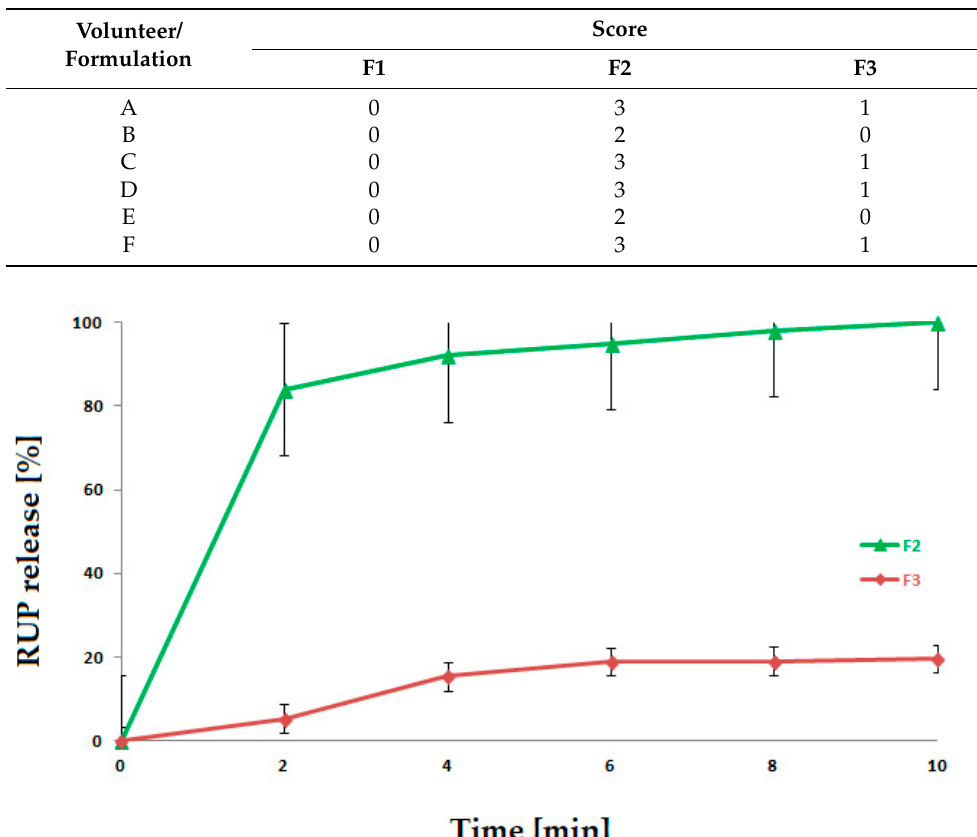
Table 2. Organoleptic assessment of formulated ODFs: 0—without bitterness, 1—slight bitterness, 2—moderate bitterness, 3—significant bitterness.